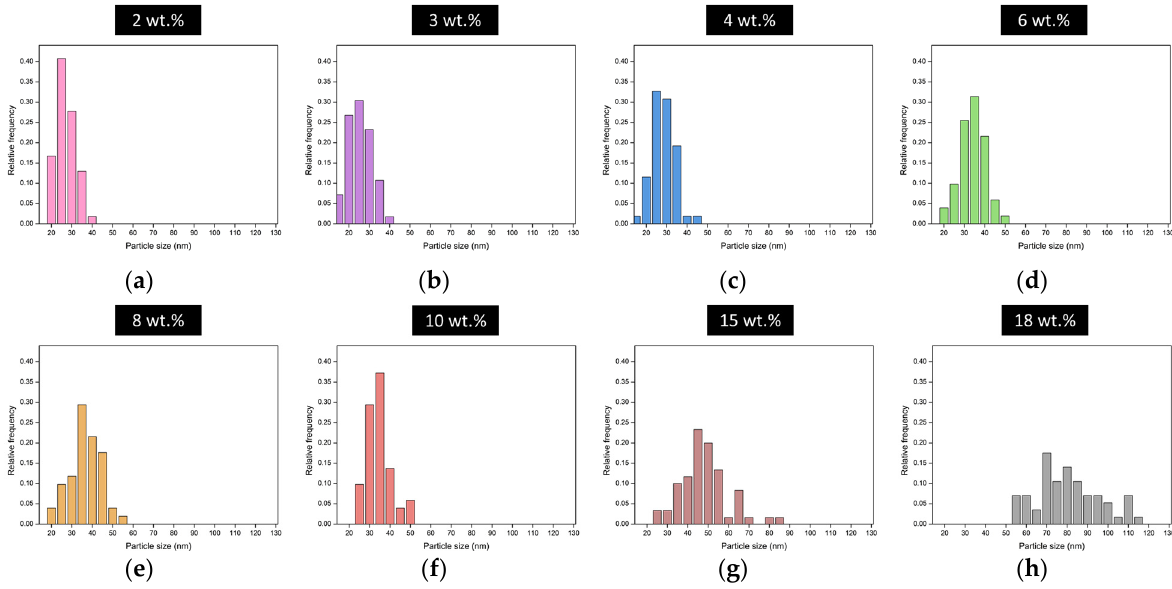
Figure 2. Particle size distribution for different aerogels produced using different catalyst contents, ( a ) 2wt.%, ( b ) 3 wt.%, ( c ) 4 wt.%, ( d ) 6 wt.%, ( e ) 8wt.%, ( f ) 10 wt.%, ( g ) 15 wt.% and ( h ) 18